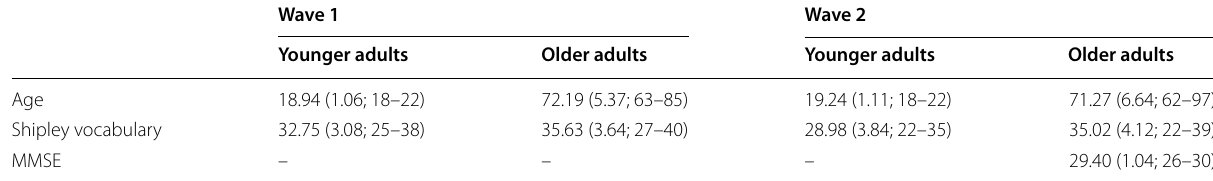
Table 1 Demographic information for all participants (standard deviations and range in